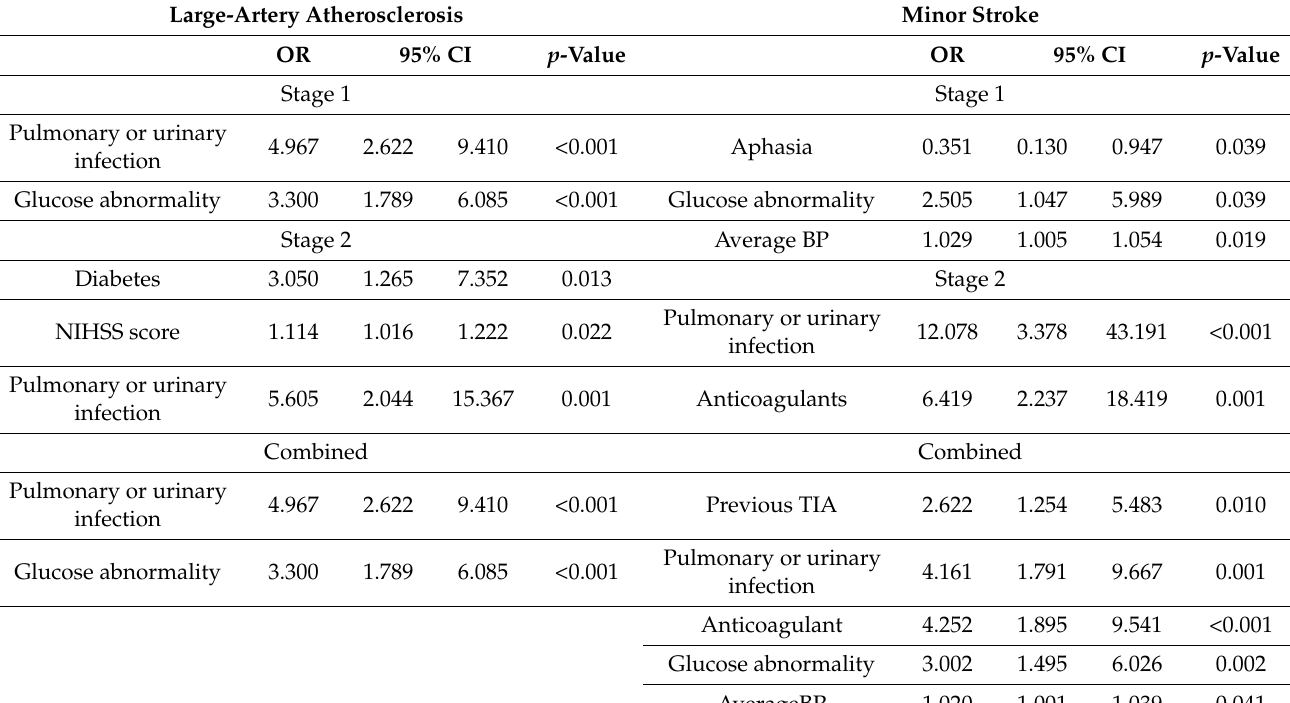
Table 4. Multivariate analysis of the factors associated with recurrent stroke in different